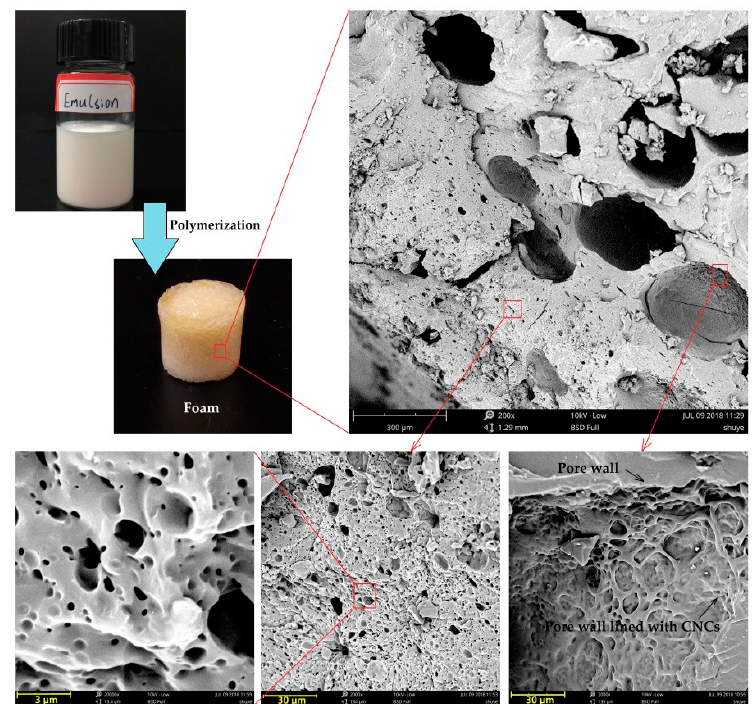
Figure 7. The visual appearance of AESO nanocomposite foam and corresponding scanning electron microscopy (SEM) images at different magnification. The foam is derived from a Pickering emulsion with 2 wt % of CNCs and an oil to water ratio of 1:1.